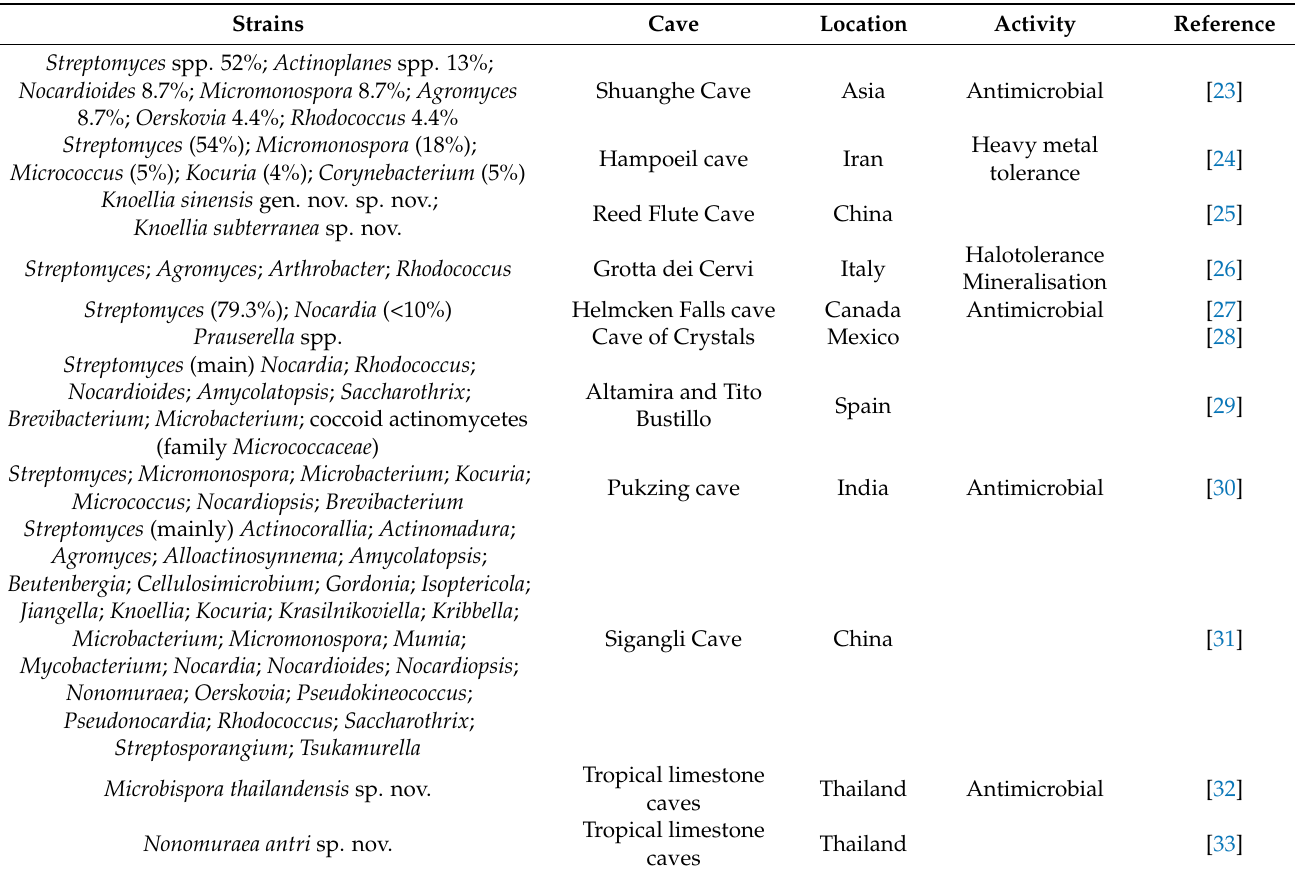
Table 1. Summary of the actinomycetes isolated from